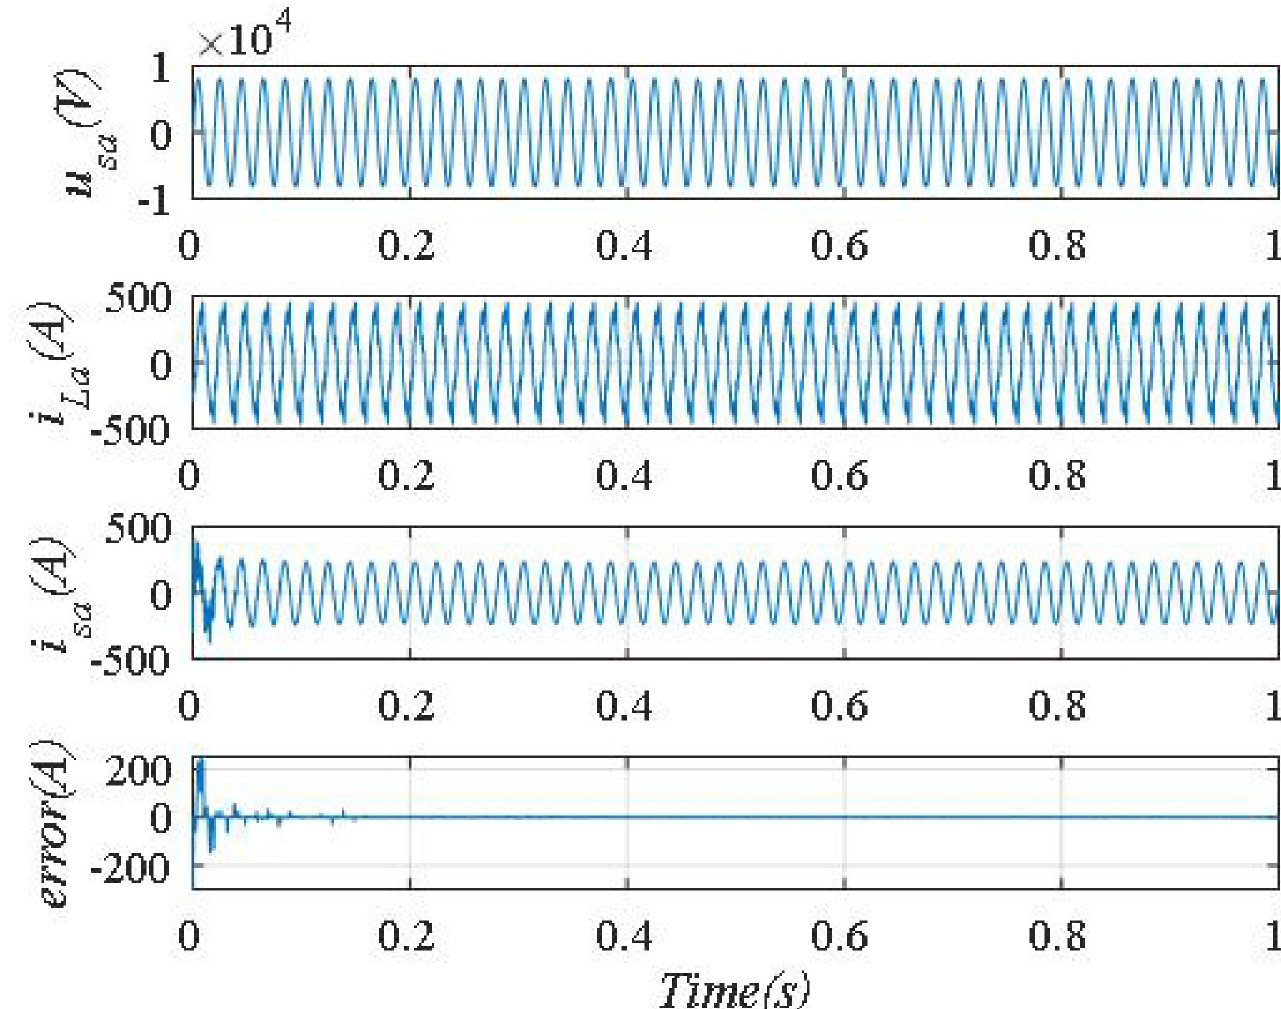
Fig 9. The waveforms corresponding to the best parameter set using the Jaya algorithm.